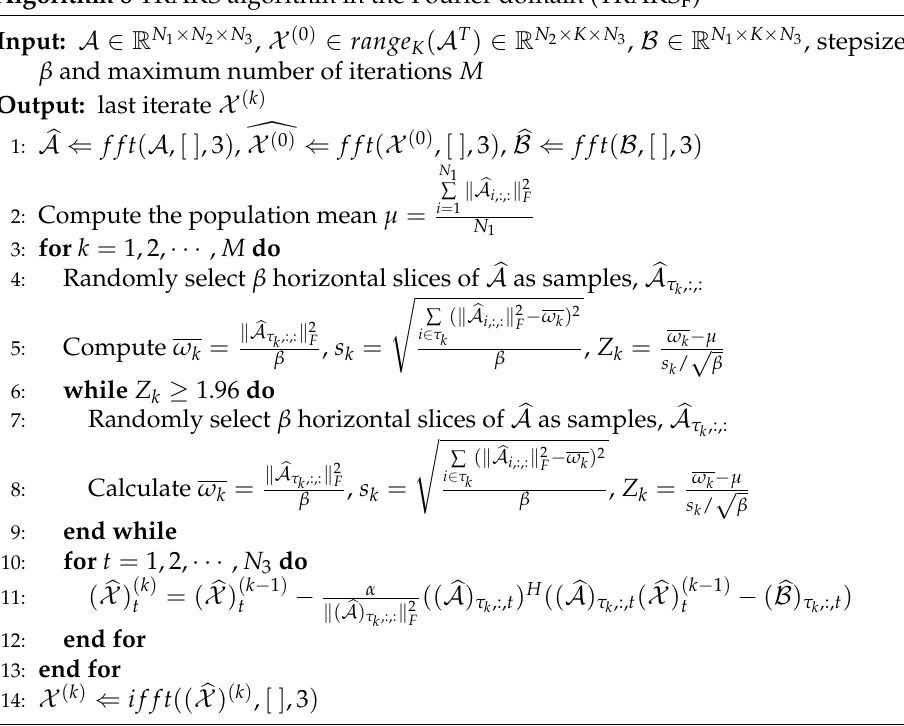
Algorithm 8 TRAKS algorithm in the Fourier domain (TRAKS F